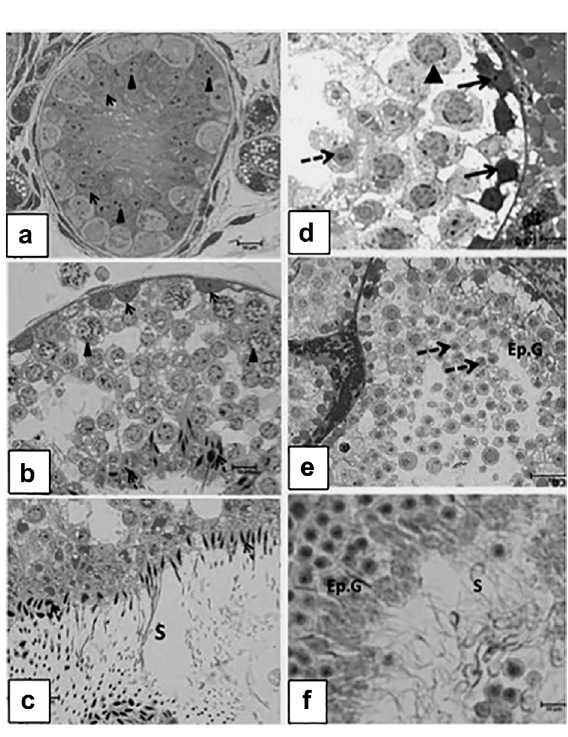
Figure 1 - Pre-pubertal cutia, spermatocytes (arrowhead), Sertoli cells (filled arrows) ( a ); Pubertal cutia, spermatocytes (arrowhead), Sertoli cells (arrows), spermatids (dashed arrows) ( b ). Adult cutia, spermatid (dashed arrows), lumen of seminiferous tubule with spermatozoa (S) ( c ) Pre-pubertal guinea pig, sertoli cells (arrows), spermatocytes (arrowhead) and spermatids (dashed arrow) ( d ). Pubertal guinea pig, germinative epithelium (Ep.G) with spermatids (dashed arrows) ( e ). Adult guinea pig, germinative epithelium (Ep.G) with spermatozoa (S) ( f ). Toluidine